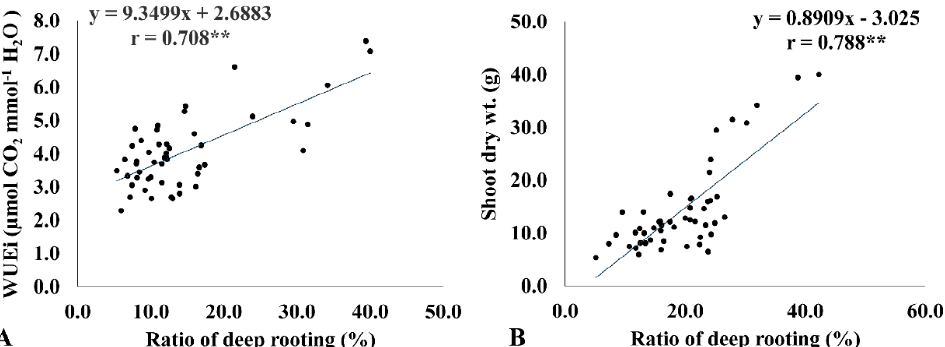
Figure 3. Linear regression relationship between the ratio of deep rooting (RDR) with instantaneous water use efficiency (WUEi) ( A ) and shoot dry weight ( B ) under drought conditions. **